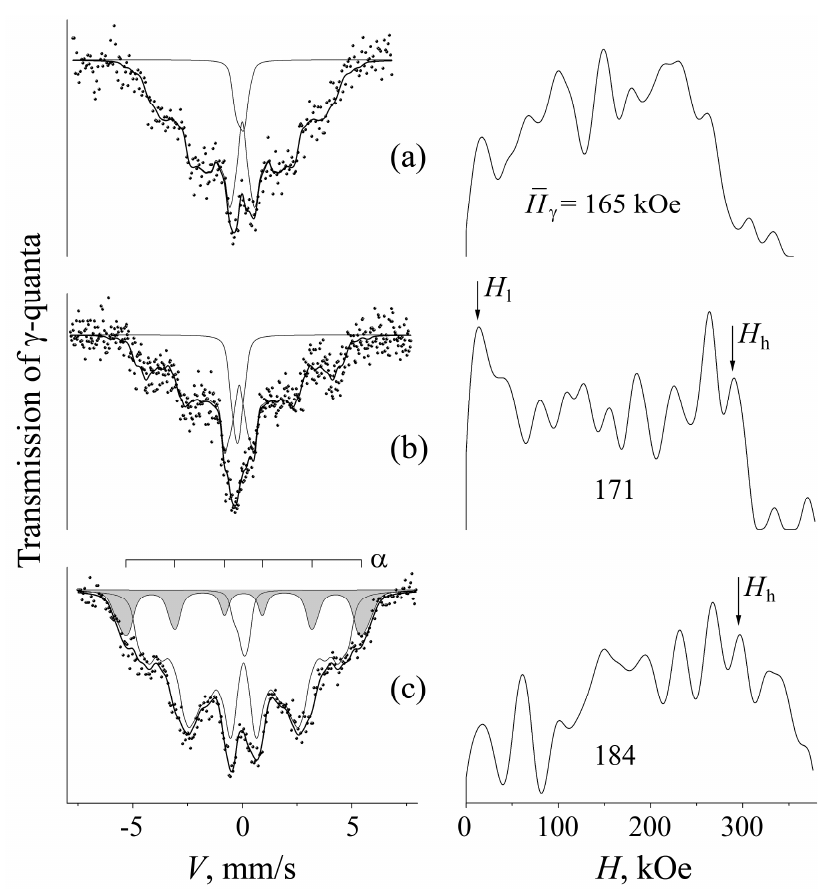
Figure 21. The spectra and distributions p ( H ) for the alloy Fe–35Ni–3Zr. Treatment (state): ( a ) annealed at 923 K for 3 h (aged); ( b ) aged and irradiated by fast neutrons with F ~ 10 20 cm − 2 at 340K; ( c ) aged and HPT treated with ε ~ 7.2 (5 rev) at 293 K. In (Figure 21) ( c ), the sextet of the α phase is marked in the spectrum. In the distributions p ( H ) the peaks H l and H h , are pointed out that correspond to the γ matrix depleted of, and enriched in, nickel.